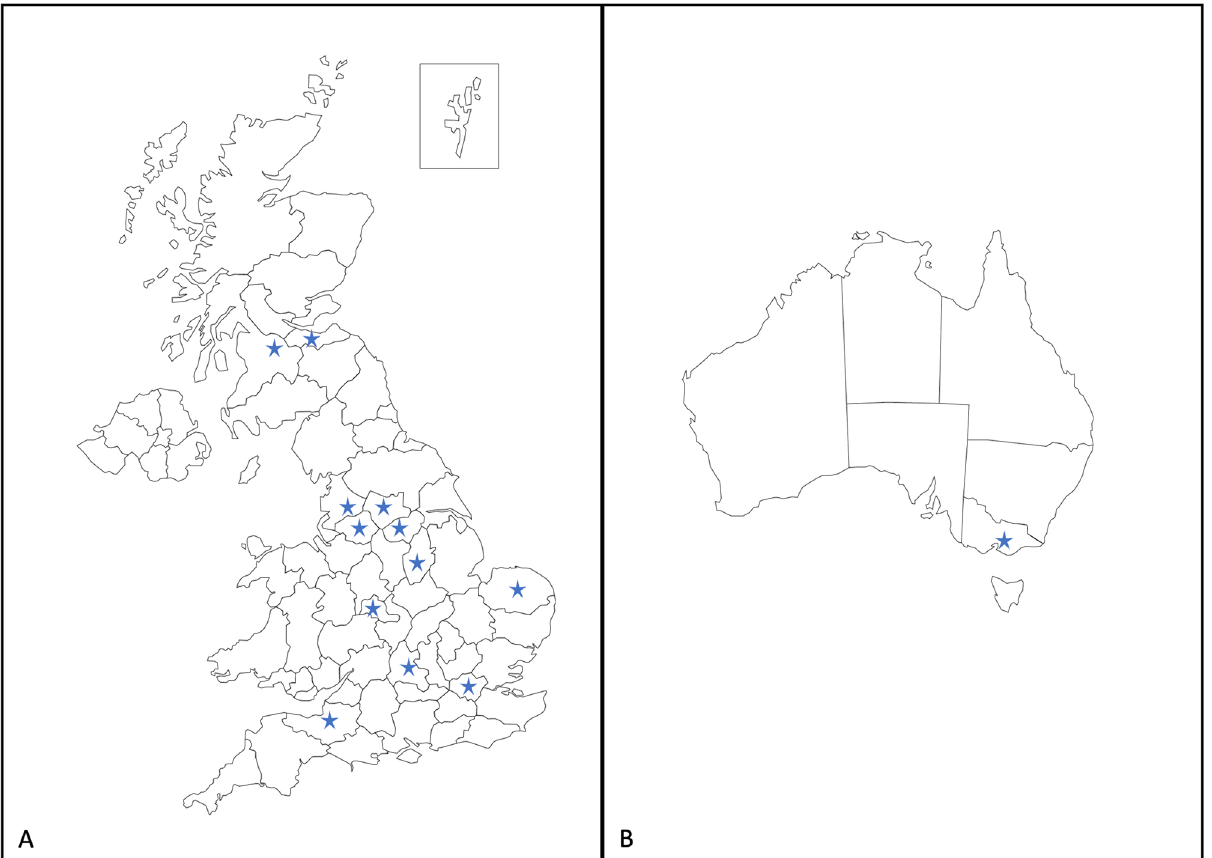
Figure 3. Map of participating sites in ( A ) UK and ( B ) Australia. Blue stars highlight the 13 hospitals that collected data for the study. Maps are modified from Bruce Jones Design 85